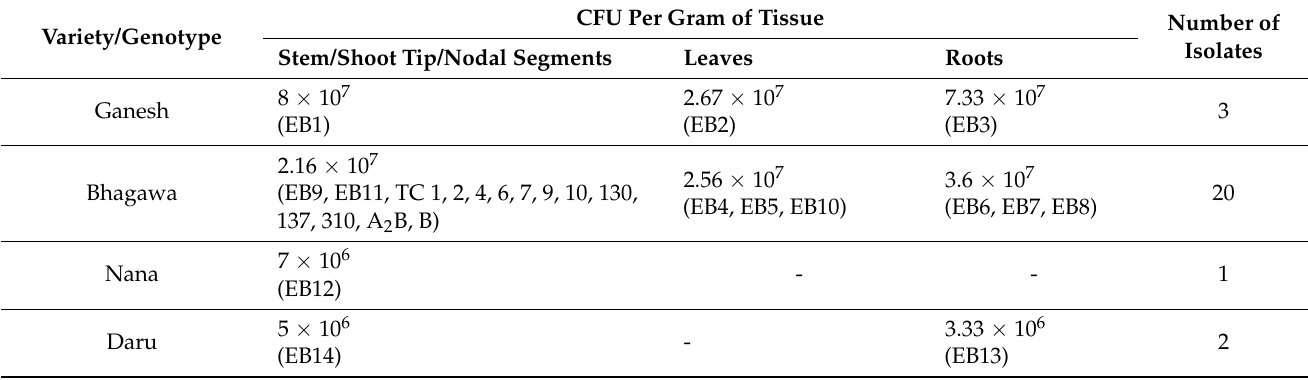
Table 1. Endogenous bacterial population size in various tissues of pomegranate. Variety/Genotype